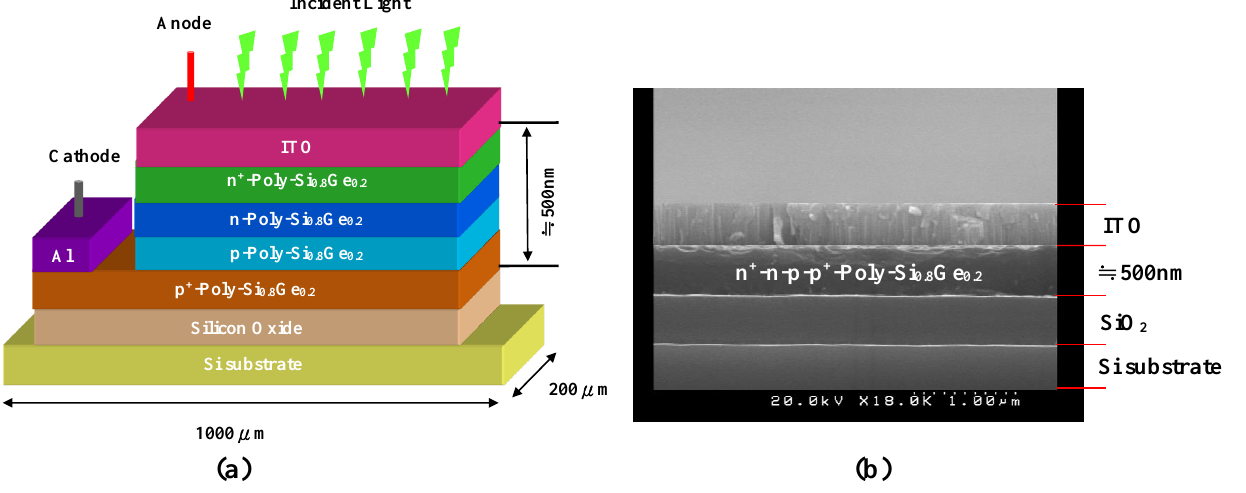
Figure 4. ( a ) Indium tin oxide (ITO)/n + -n-p-p + polySi 0.8 Ge 0.2 film and schematic APS device with aluminum (Al)/silicon dioxide (SiO 2 )/Si-substrate structure and ( b ) cross-section SEM photo of the developed APS (30 mm 2 dimension). Fig. 4 Y.-T. Cheng et . al .